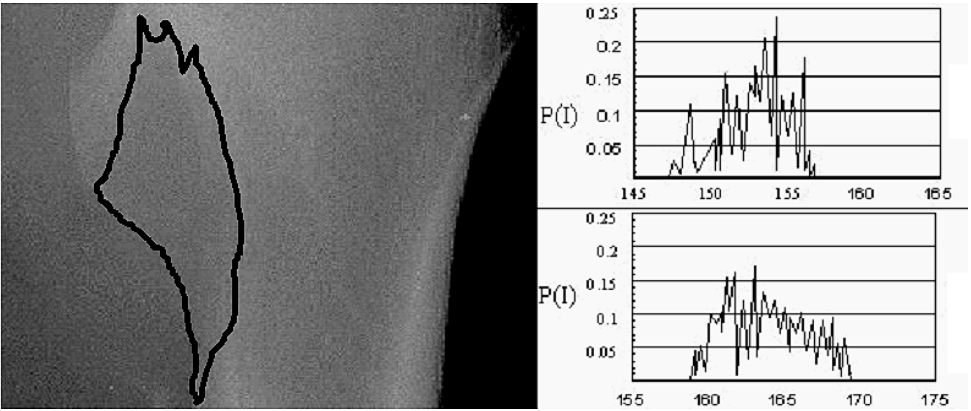
Figure 1. First ‐ order statistics as an image processing technique for the evaluation of recalcification of bone lytic metastasis at the femur after radiotherapy. Mean value and energy (MVGLH, EGLH) at baseline (EGLH = 0.19, MVGLH = 155.1) and six months after initiation of multimodality treatment (EGLH = 0.17, MVGLH = 173.3). P ( I ) refers to the probability of intensity ( I ).